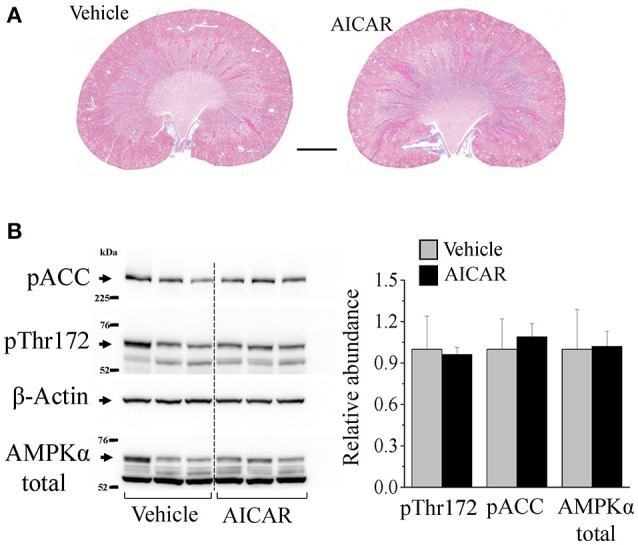
AICAR treatment does not affect renal damage and cortical AMPK activity. (A) Kidney morphology. Trichrome staining revealed that AICAR treatment did not preclude renal damage in SS hypertension. Scale bar = 2 mm. (B) Abundance of total AMPKα, phosphorylated Thr172-AMPKα and phosphorylated acetyl-CoA carboxylase (pACC), a canonical target of AMPK were studied in the renal cortex collected from the infused animals. No difference in AMPK activity was found between the groups.